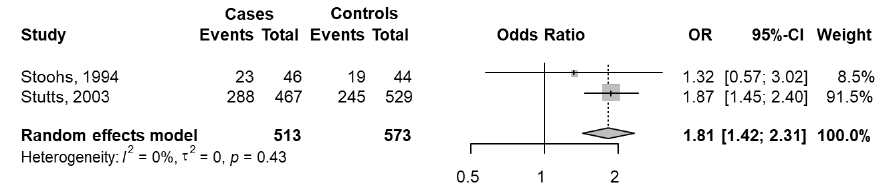
Figure 9. The forest plot of the meta-analysis of sleep-disordered breathing (SDB) and car crashes [33,57]. Events Cases are defined as total car crashes in subjects with SDB (total 311), and Total Cases indicate Total subjects with SDB (total 513). Controls Cases are defined as car crashes in subjects without SDB (total 264), and Total Cases indicate total subjects without SDB (total 573). The whiskers represent the 95% confidence interval (CI). The diamond represents the pooled OR estimate based on the random effects model, with the center representing the point estimate and the width the associated 95% CI. I 2 describes the percentage of the variability in effect estimates that is due to heterogeneity rather than sampling error, ranging from 0 (no heterogeneity) to 100 (maximum het- erogeneity).